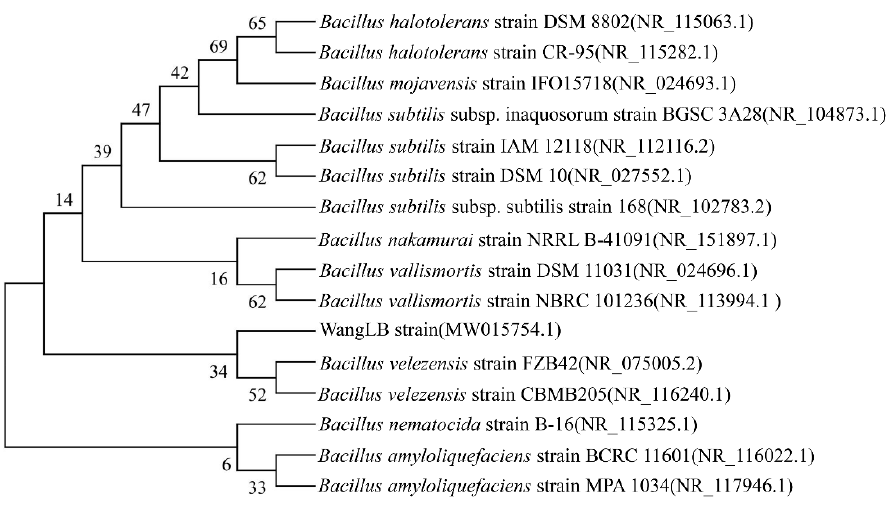
Figure 2. Phylogenetic analysis of the WangLB 16S rDNA with related bacteria. MEGA X was used and the maximum likelihood algorithm was selected to construct the tree with 1000 bootstraps and nucleotide Tamura-Nei substitution model.